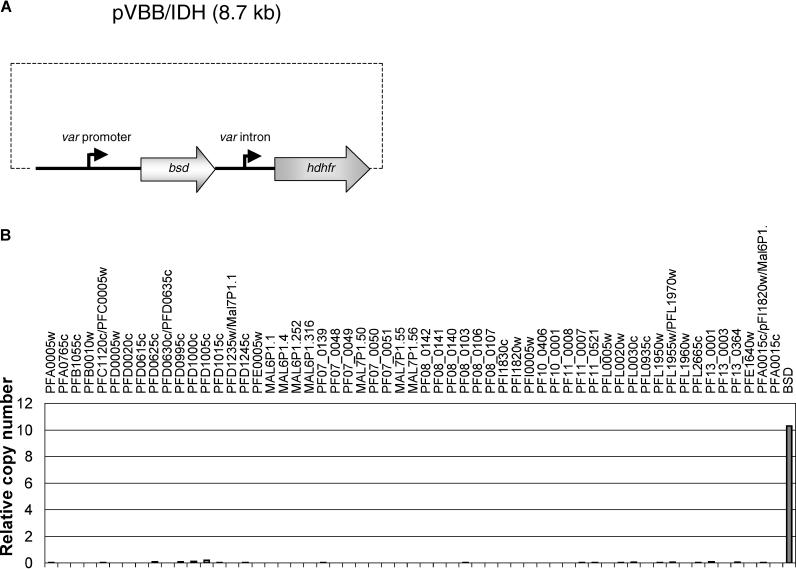
An Active var Promoter on an Episome Is Exclusively ExpressedNF54/C3 parasites stably carrying the episome pVBB/IDH were grown under blasticidin pressure.(A) Plasmid map of pVBB/IDH.(B) Transcription levels were then measured by Q-RT-PCR and indicated that the parasites exclusively express bsd while all endogenous var genes are silent.